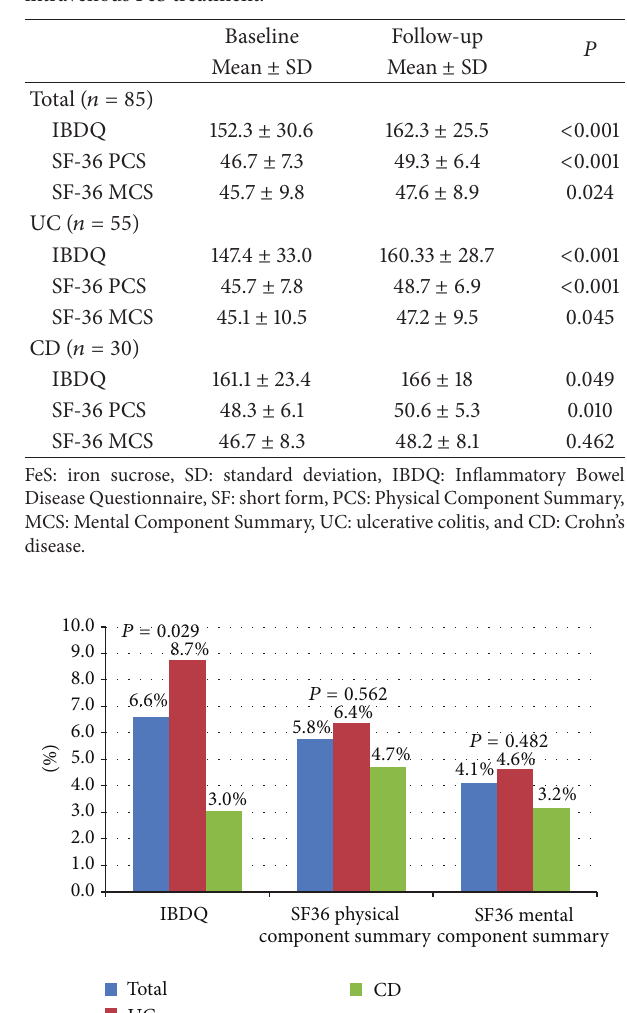
Table 2: Comparison of quality of life parameters before and after intravenous FeS treatment.